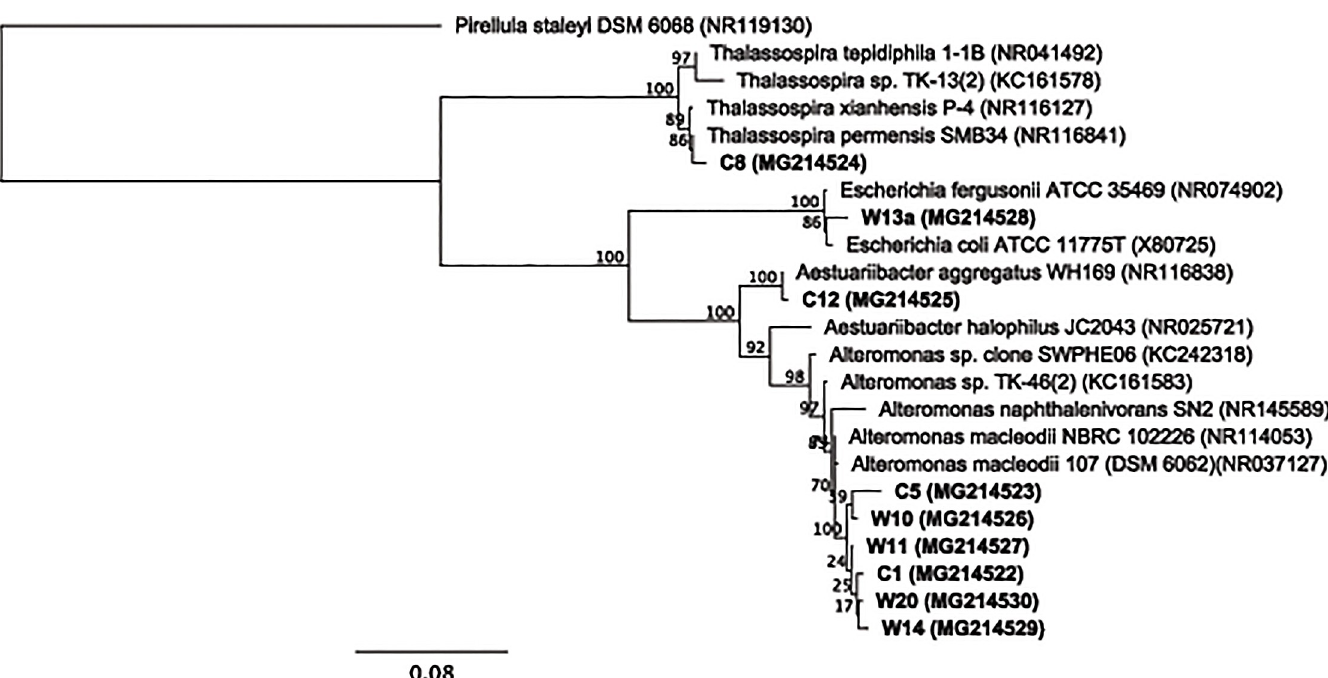
Fig 1. Phylogenetic tree (maximum likelihood: 100 bootstrap replicates) of the isolates, their closest relatives, and other strains isolated from the Gulf of Mexico.